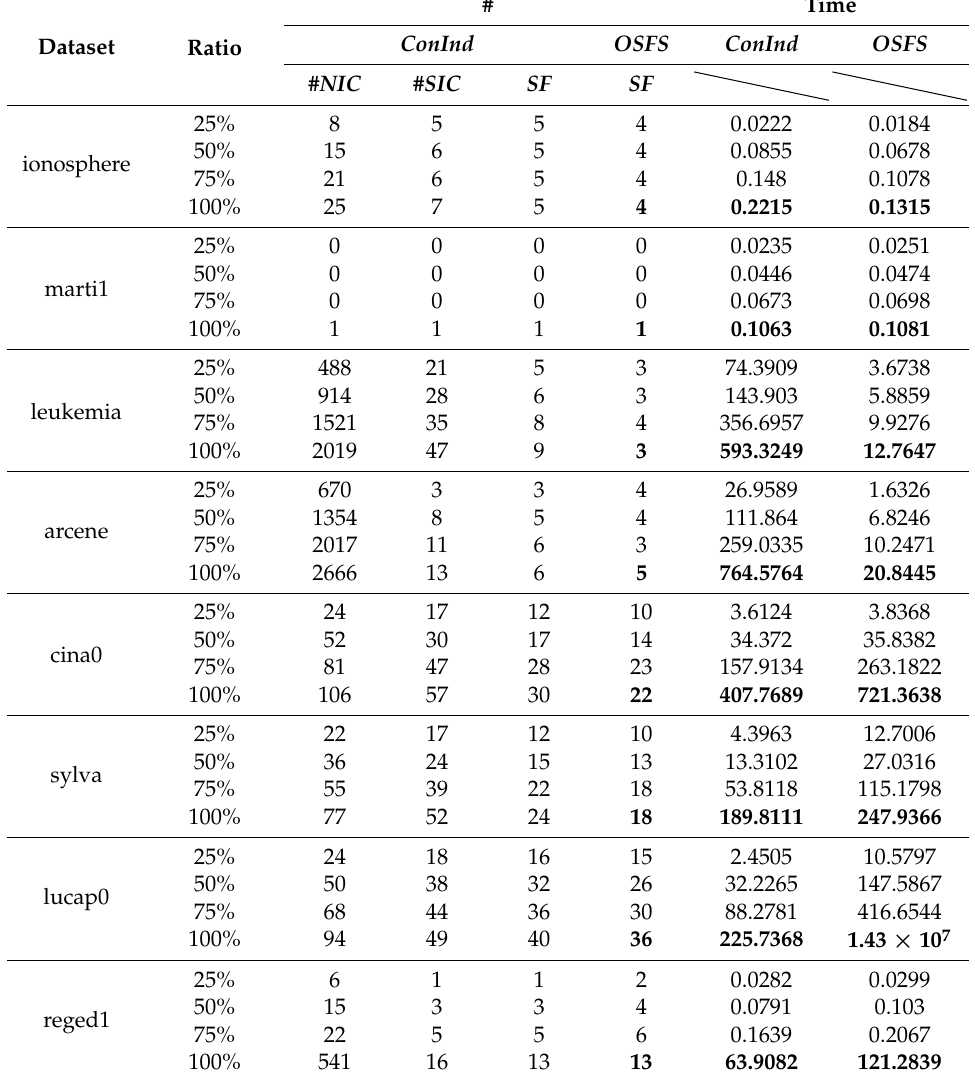
Table 8. Variation in the number of selected features and running time with the ratio of feature space.